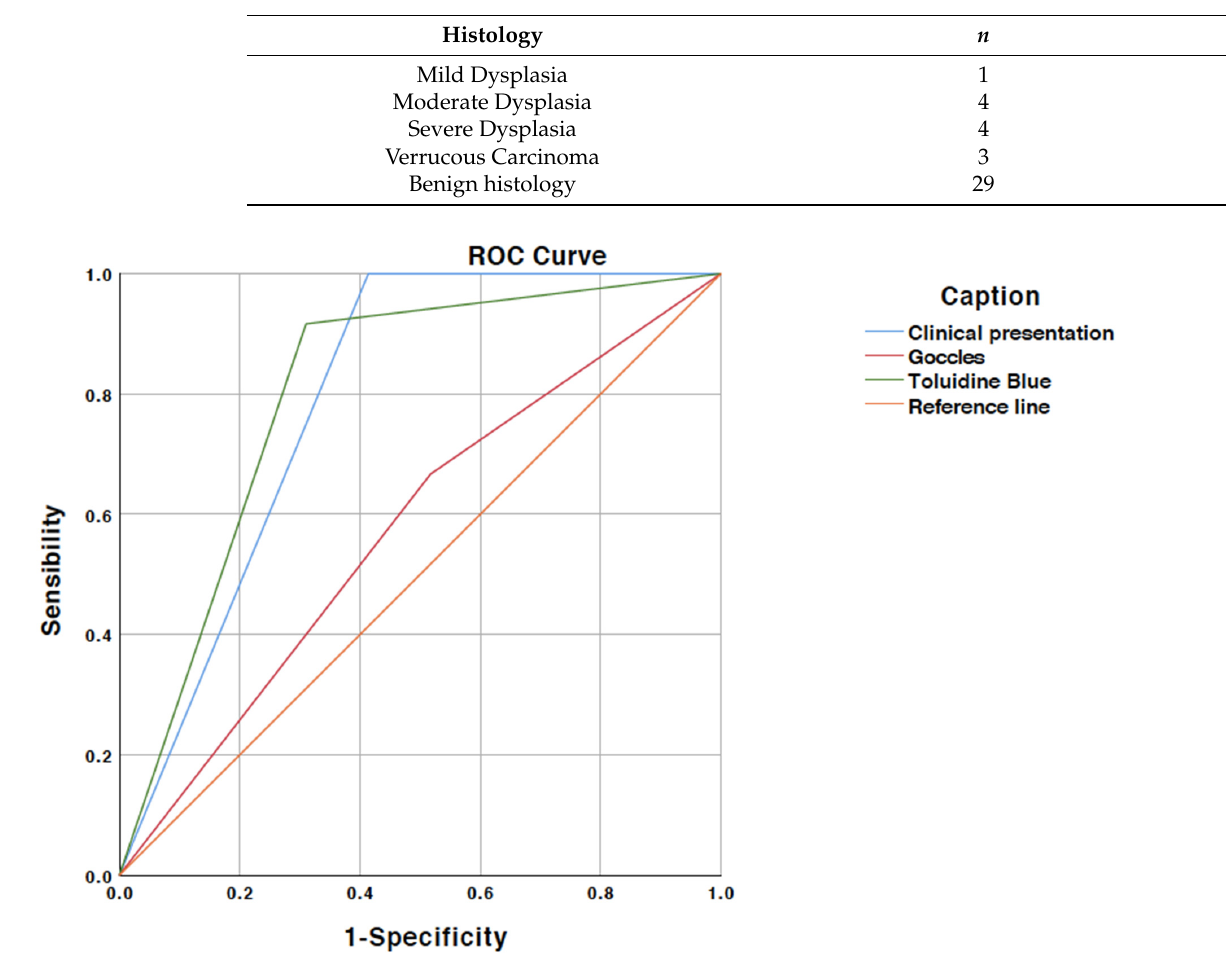
Table 6. Histological results ( n = 41).